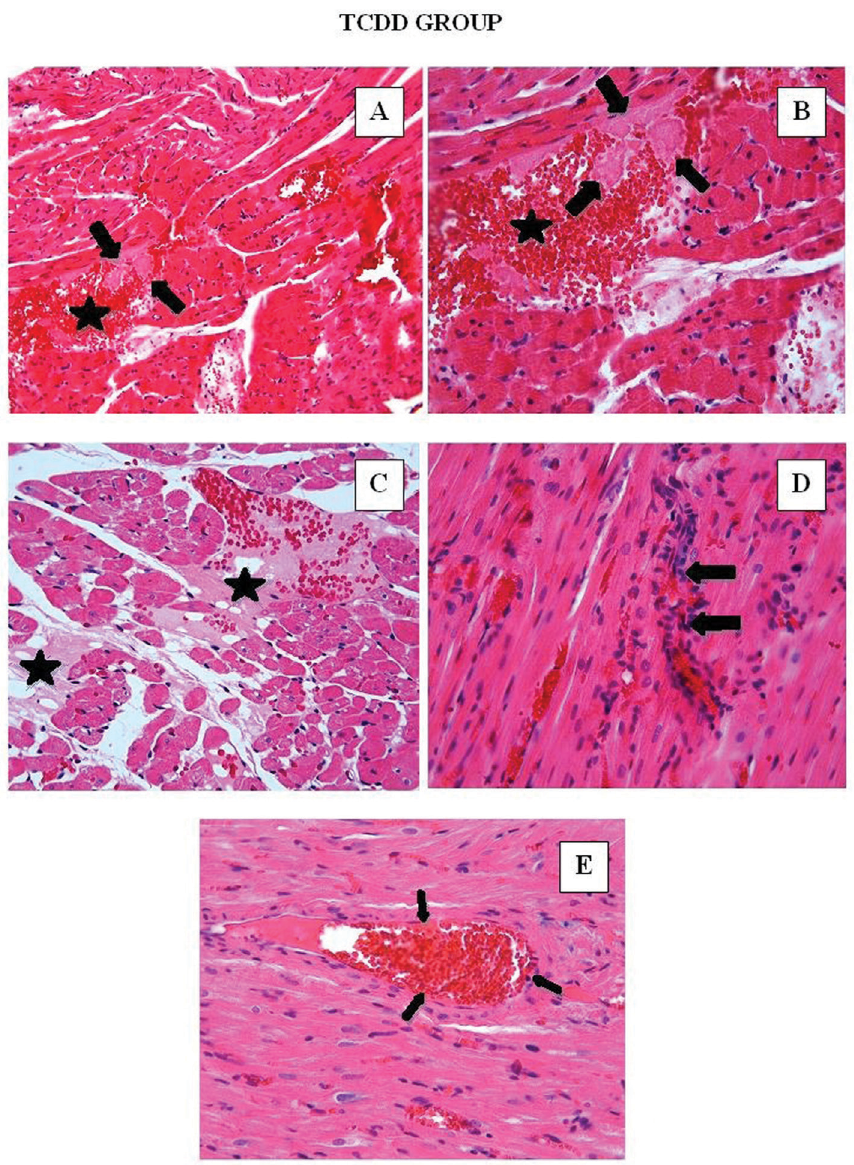
FIGURE 2 - TCDD group. Eosinophilic stained and pyknotic nuclei cells, necrosis (A,B), hemorrhage (A,B,C,D), mononuclear cell infiltration (D), oedema (arrows) (C), vascular congestion (E) and vacuolisation (C). A, B: H-E; X20, C, D, E: H-E;